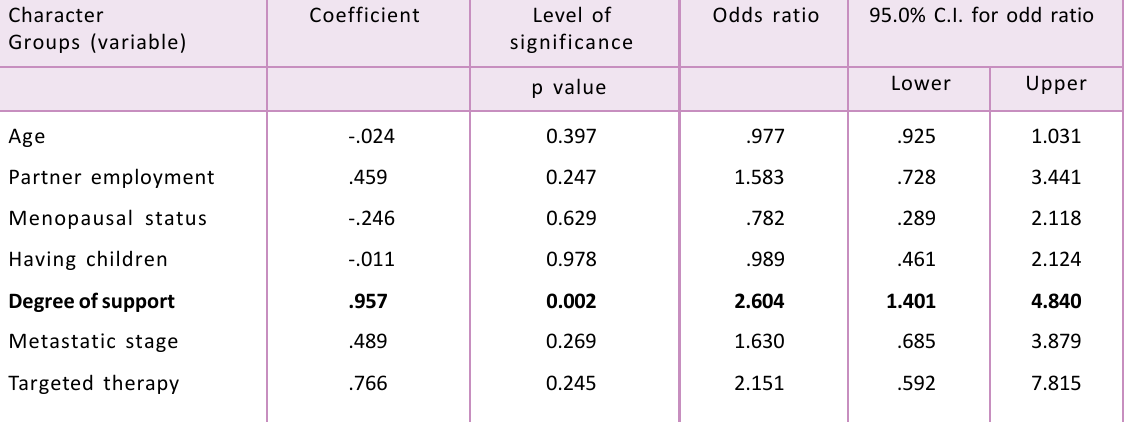
Table 2. Factors associated with depression in patients with breast cancer – logistic regression